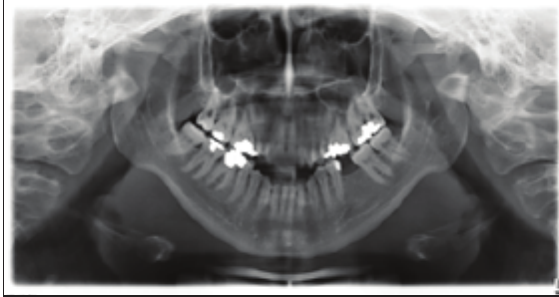
Figure 4. Pretreatment panoramic radiograph of the patient.